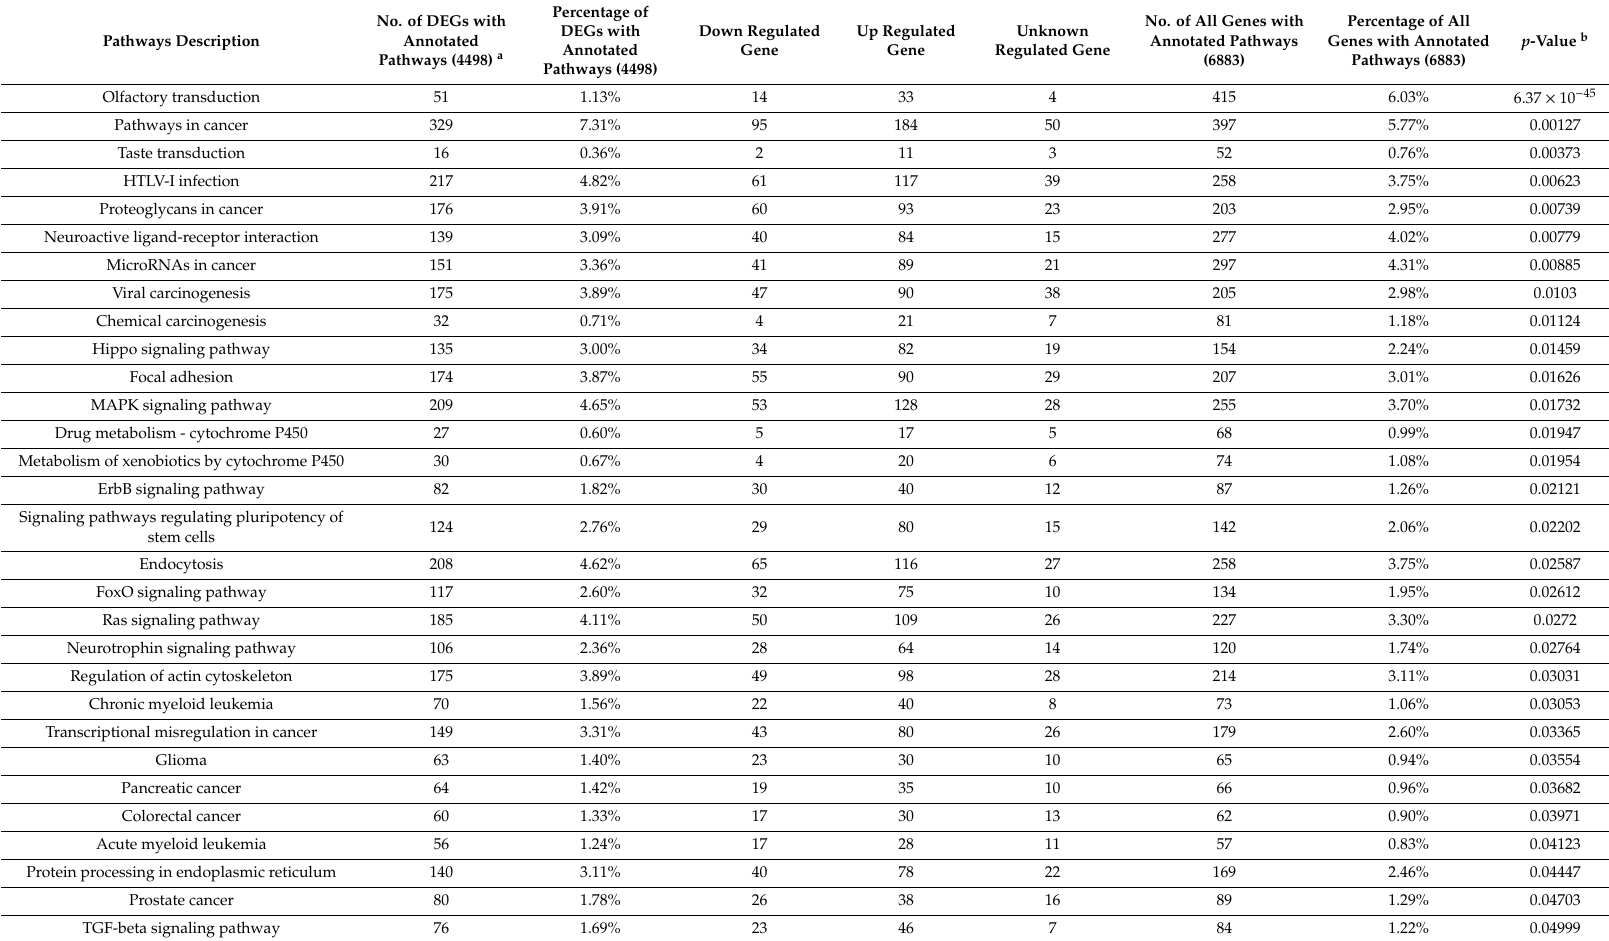
Table 4. Thirty significant changed pathways after repeated doses of 188 Re-liposome